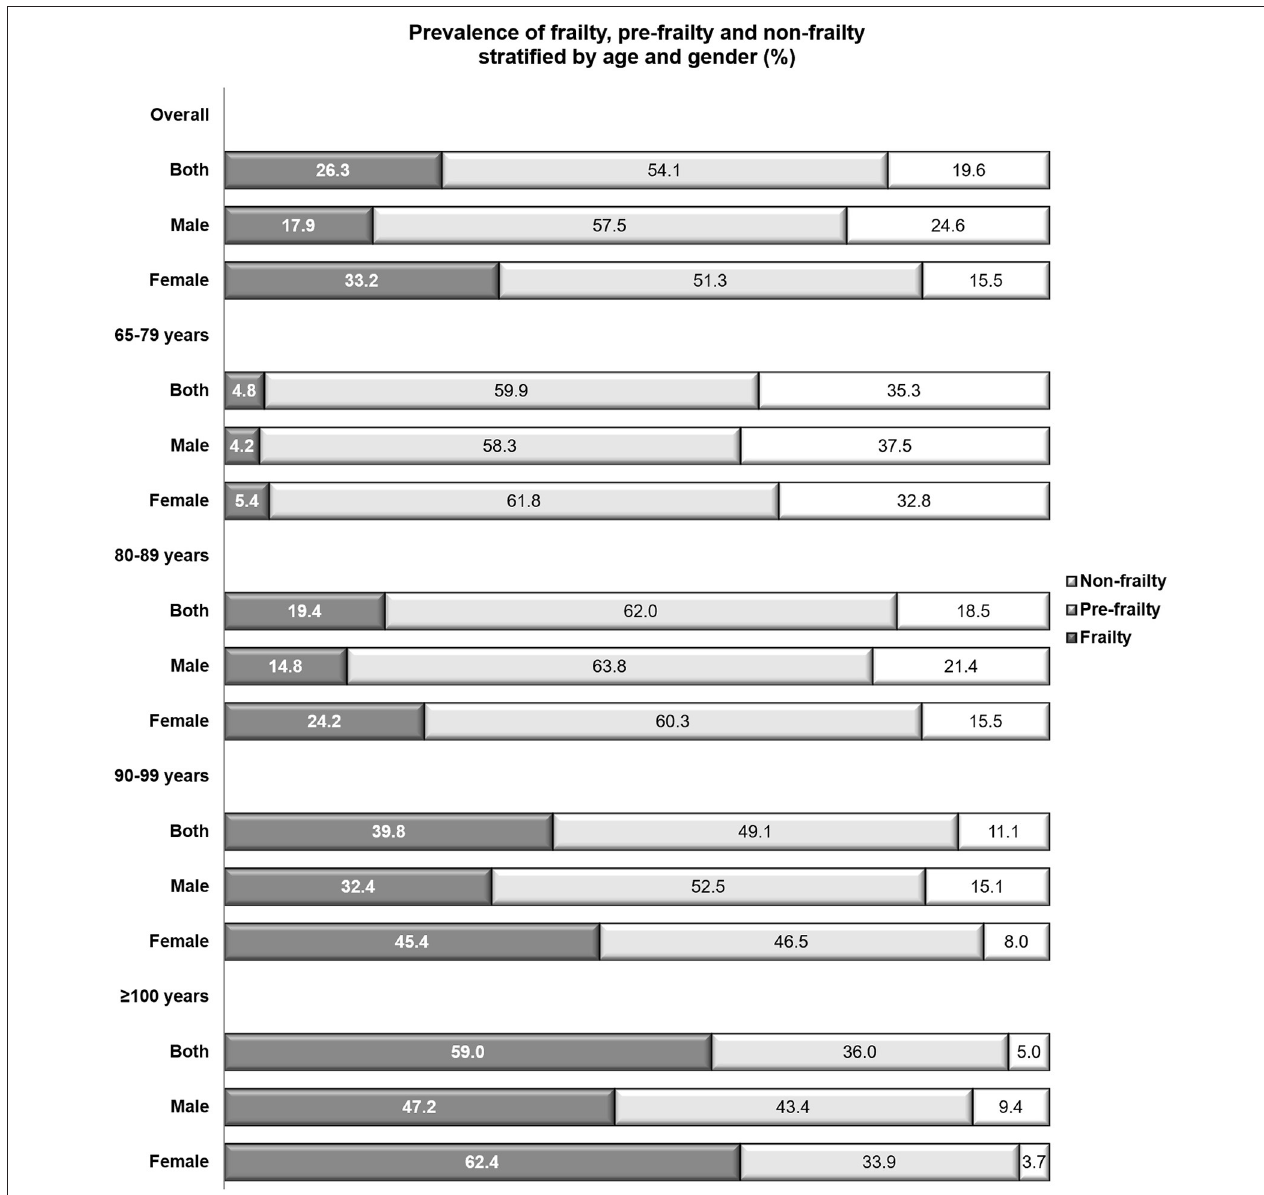
FIGURE 1 | Prevalence of pre-frailty, frailty and non-frailty, age-, and gender-stratified.